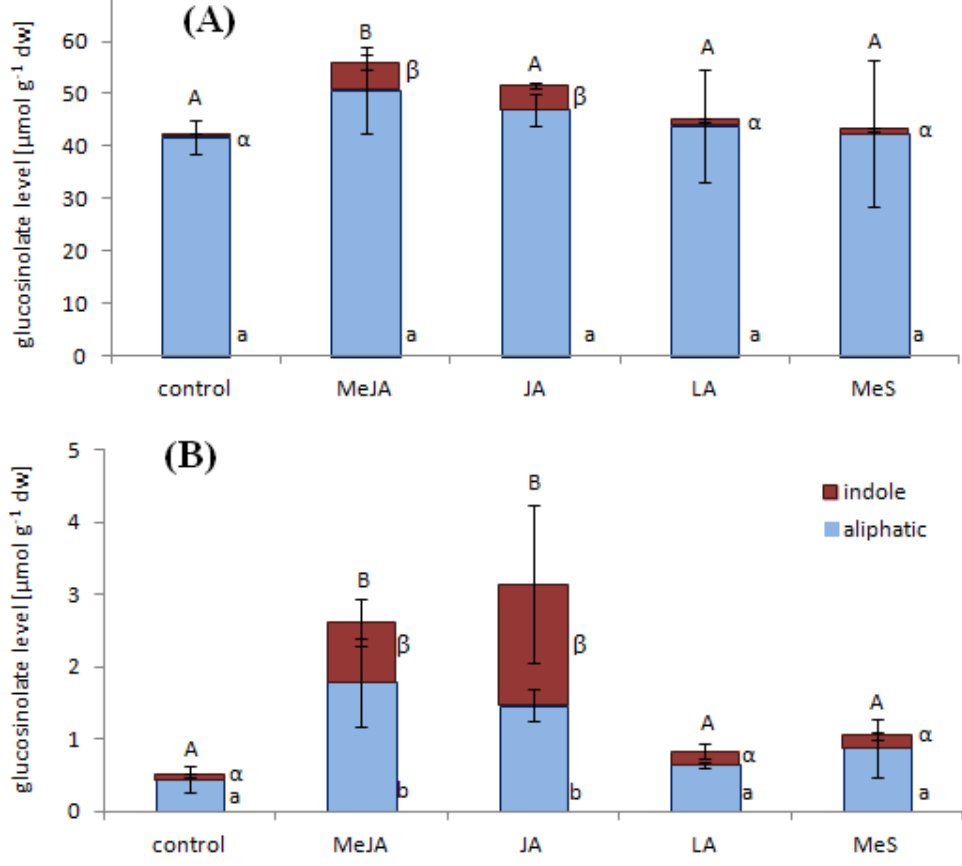
Figure 3. Glucosinolate levels in sprouts and mature leaves. Sprouts ( A ) and mature leaves ( B ) were harvested 48 h after elicitor or control treatment. Glucosinolate levels are shown as mean value with standard deviation ( n = 5) of total aliphatic (blue) and total indole glucosinolates (red) in µmol g − 1 dry weight (for details see Table S1). Elicitors: MeJA, methyl jasmonate; JA, jasmonic acid; LA, linolenic acid; MeS, methyl salicylate. Significant differences of total glucosinolate levels are labeled with different capital letters ( A , B ); significant differences of aliphatic glucosinolates are labeled with different Arabic letters (a,b); significant differences of indole glucosinolates are labeled with